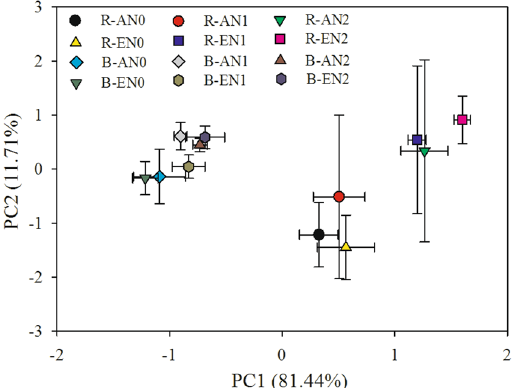
Figure 4. Principal component (PC) analysis of the PLFAs in the rhizosphere and bulk soil in the treatments. R, rhizospheric soil; B, bulk soil; AN0, ambient CO 2 and no N added; AN1 ambient CO 2 and N supply at a rate of 2.5 g N m − 2 y − 1 ; AN2, ambient CO 2 and N supply at a rate of 5 g N m − 2 y − 1 ; EN0, elevated CO 2 and no N added; EN1, elevated CO 2 and N supply at a rate of 2.5 g N m − 2 y − 1 ; EN2, elevated CO 2 and N supply at a rate of 5 g N m − 2 y − 1